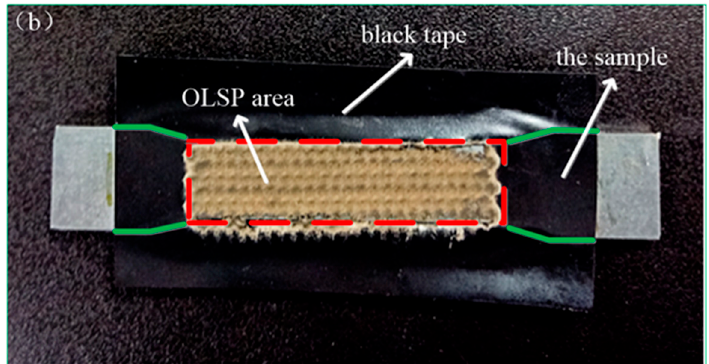
Figure 3. OLSP schematic diagram and the sample after OLSP. ( a ) The OLSP schematic diagram. ( b ) the sample after OLSP.